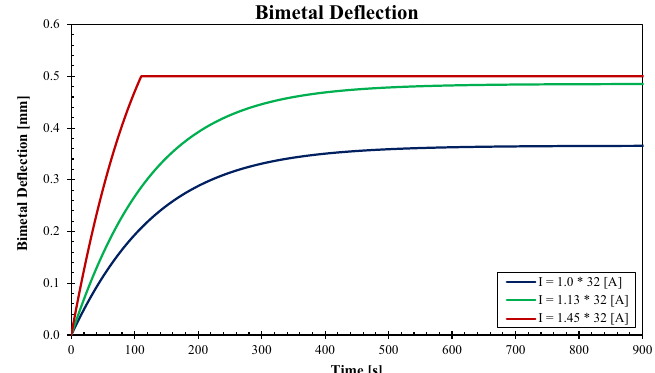
Figure 9. Deflection of the BM-4 over the time for I n = 32A and other current conditions of 1.13 × I n and 1.45 × I n .